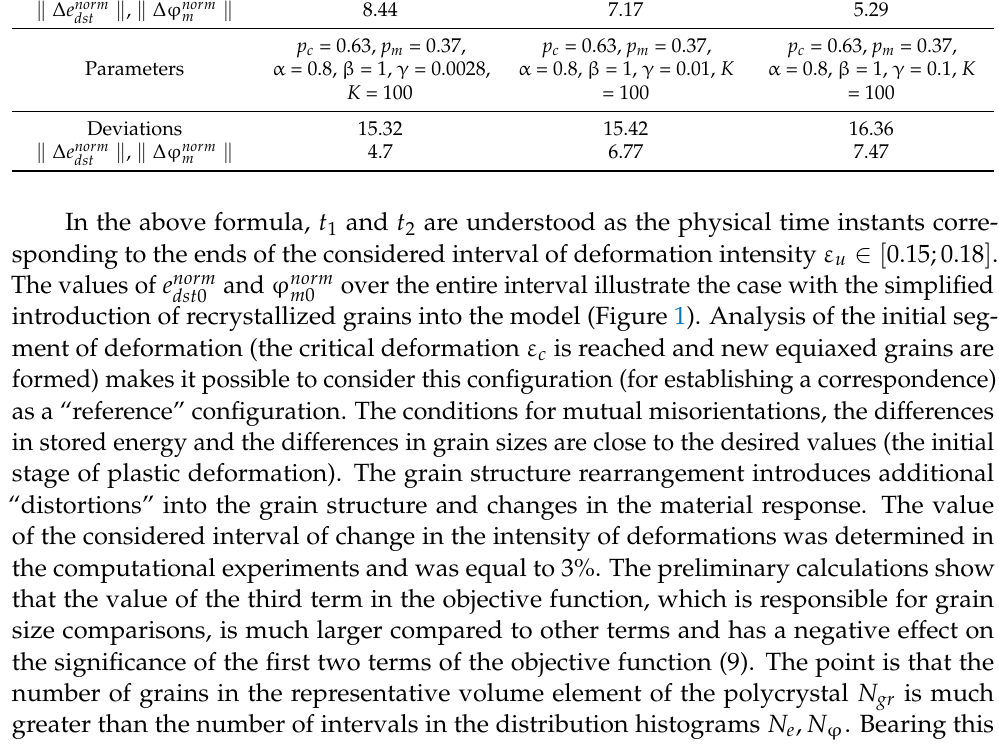
(cid:107) and (cid:107) ∆ ϕ norm (cid:107) at different values of the genetic m dst